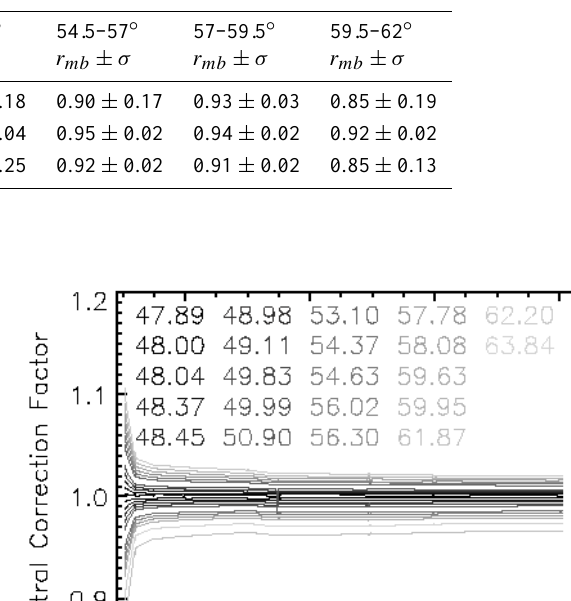
Table 2. Agreement between the downwelling erythemal irradiance measured by the SL501 and the spectroradiometer. The mean ratio SL501/Spectroradiometer ( r mb ) and the standard deviation σ are listed for the SZA ranges occurring during the albedo measurements. Additionally, a separation in cloudless and overcast situations is shown.